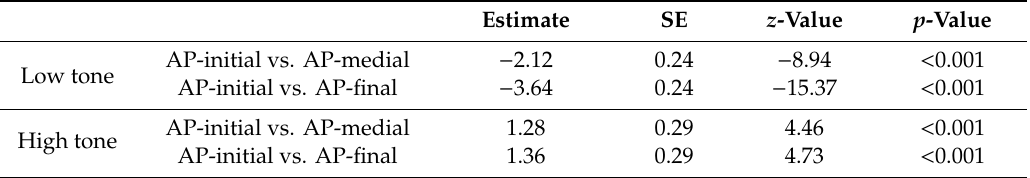
Table 2. Results of the multiple comparison analysis for AP position in the low tone group (Estimate: Coe ffi cient estimates, SE: Standard error).